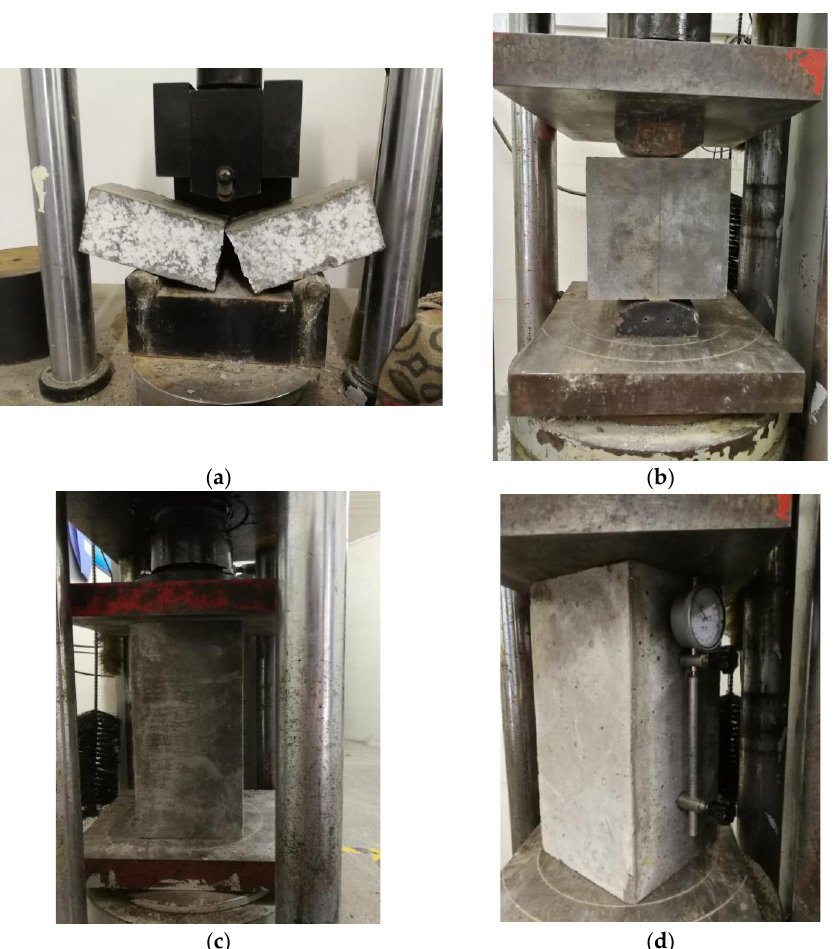
Figure 6. Tests to measure the material properties of the H-40 grouting material: ( a ) rupture strength, ( b ) splitting tensile strength, ( c ) axial compressive strength, and ( d ) elastic modulus. The sleeve was made of Q235 seamless steel pipe. Uniaxial tension tests of three dog-